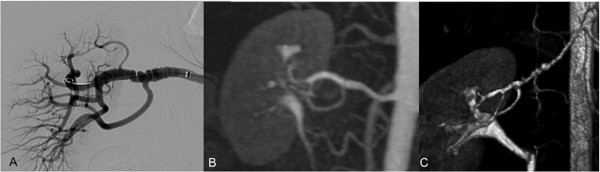
This case illustrates the benefits of higher fields strengths for MRA: in distinction to DSA (A), on which a string-and-bed like appearance of the right renal artery consistent with fibromuscular disease is depicted clearly, this morphology is hardly visible on the corresponding MRA scan (B), acquired on a 1.5 T scanner. Thin MIP reconstructions of a renal MRA, performed on a 3 T scanner in a different patient (C), demonstrate similar vessel changes very clearly.